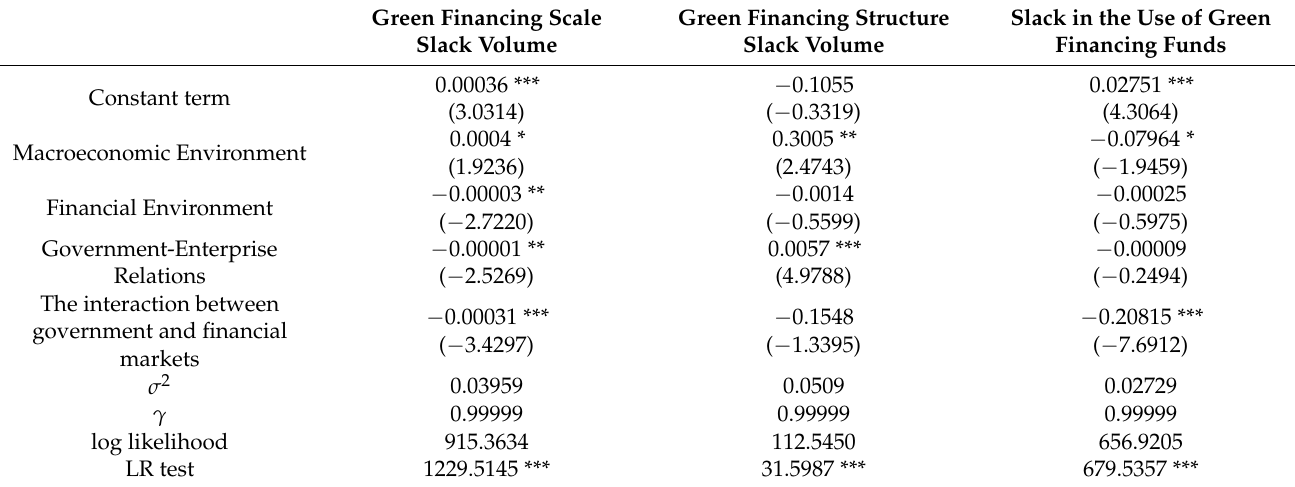
Table 5. Second-stage SFA regression